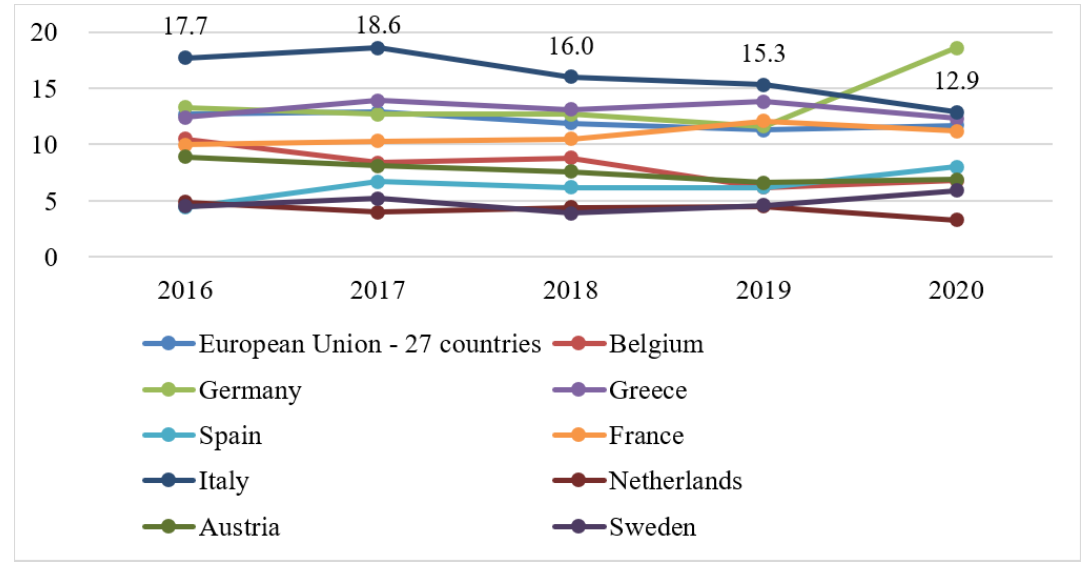
Figure 11. The inability to eat meat or proteins regularly in Europe, 2016–2021. Source: own elaboration on the Eurostat